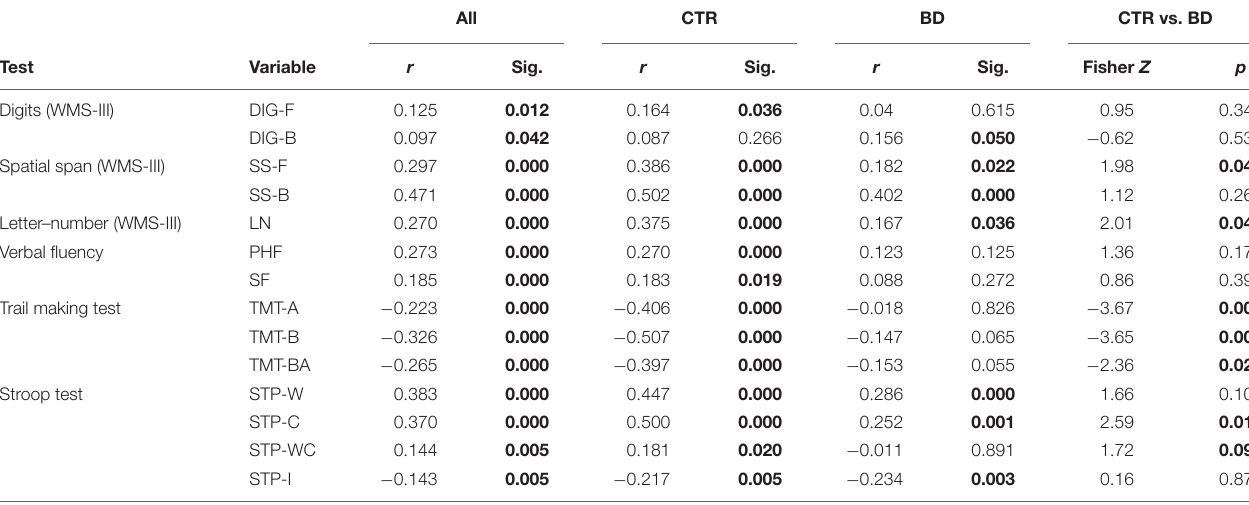
TABLE 2 | Correlations between age of the subjects and the scores in the executive tasks, first in the whole sample and after, separated by groups. All CTR BD CTR vs. BD